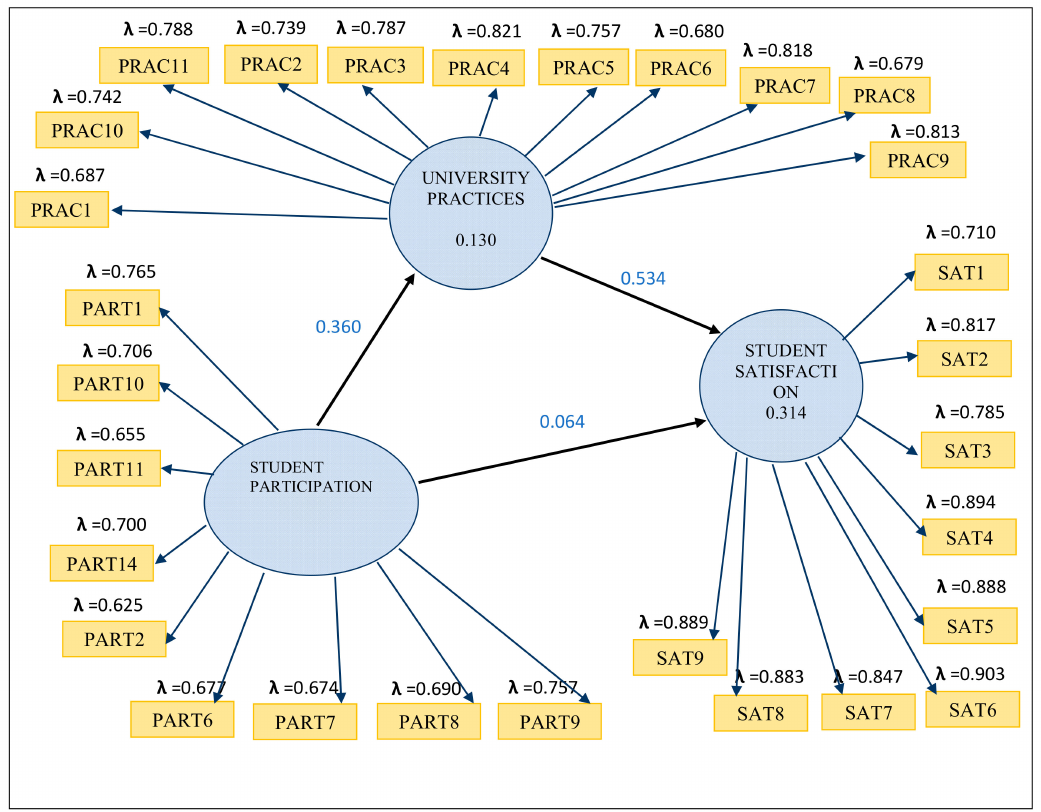
Figure 2. Nomogram of the model. Source: